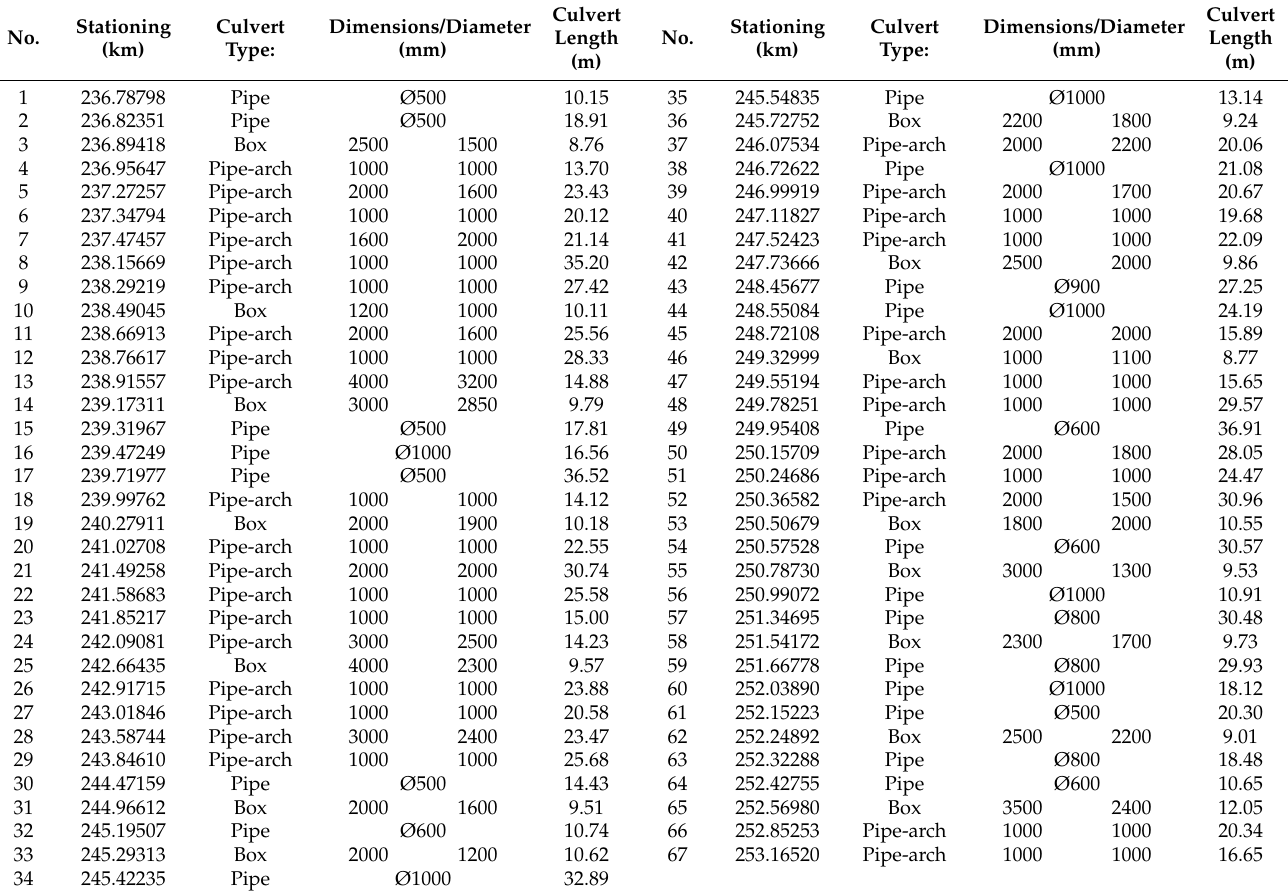
Table 1. Specific data of the analyzed road culverts.